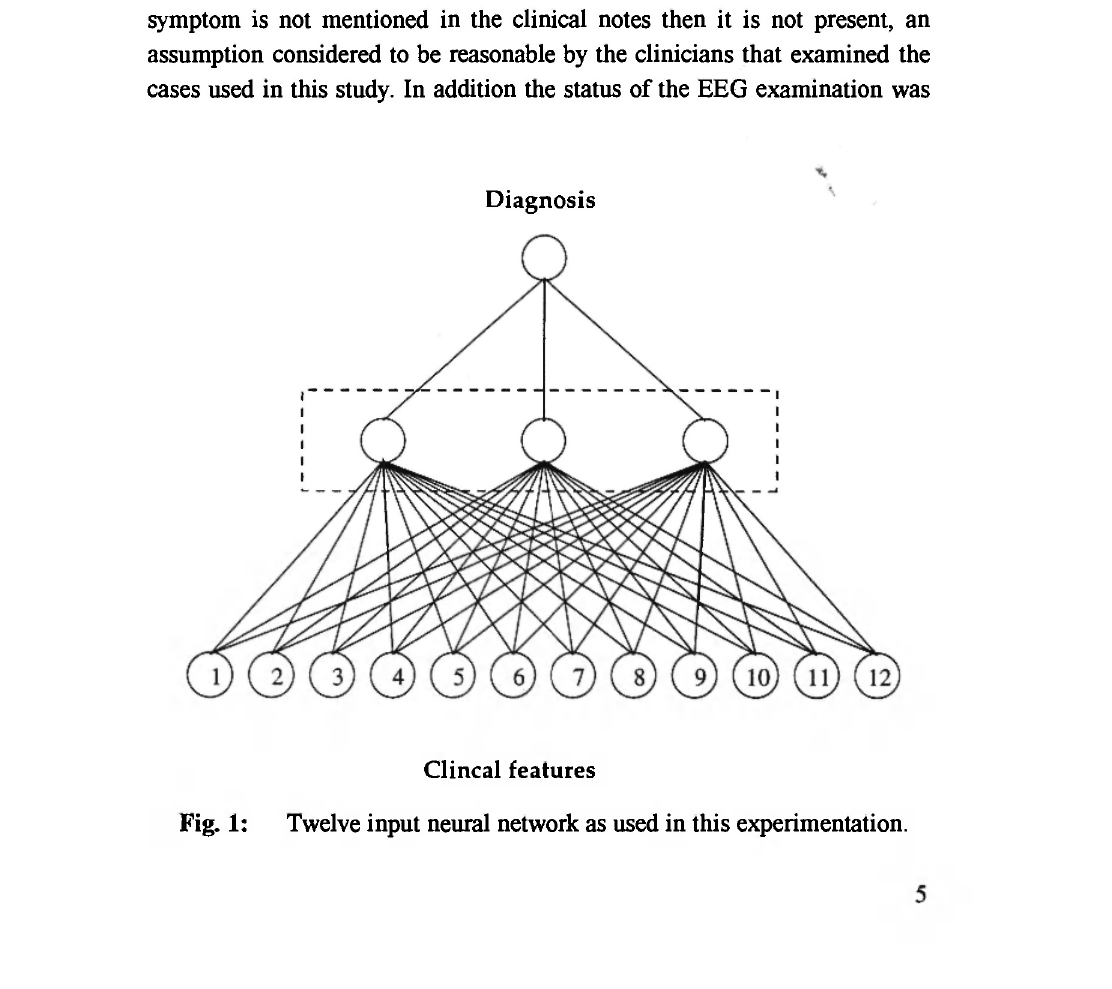
Fig. 1: Twelve input neural network as used in this